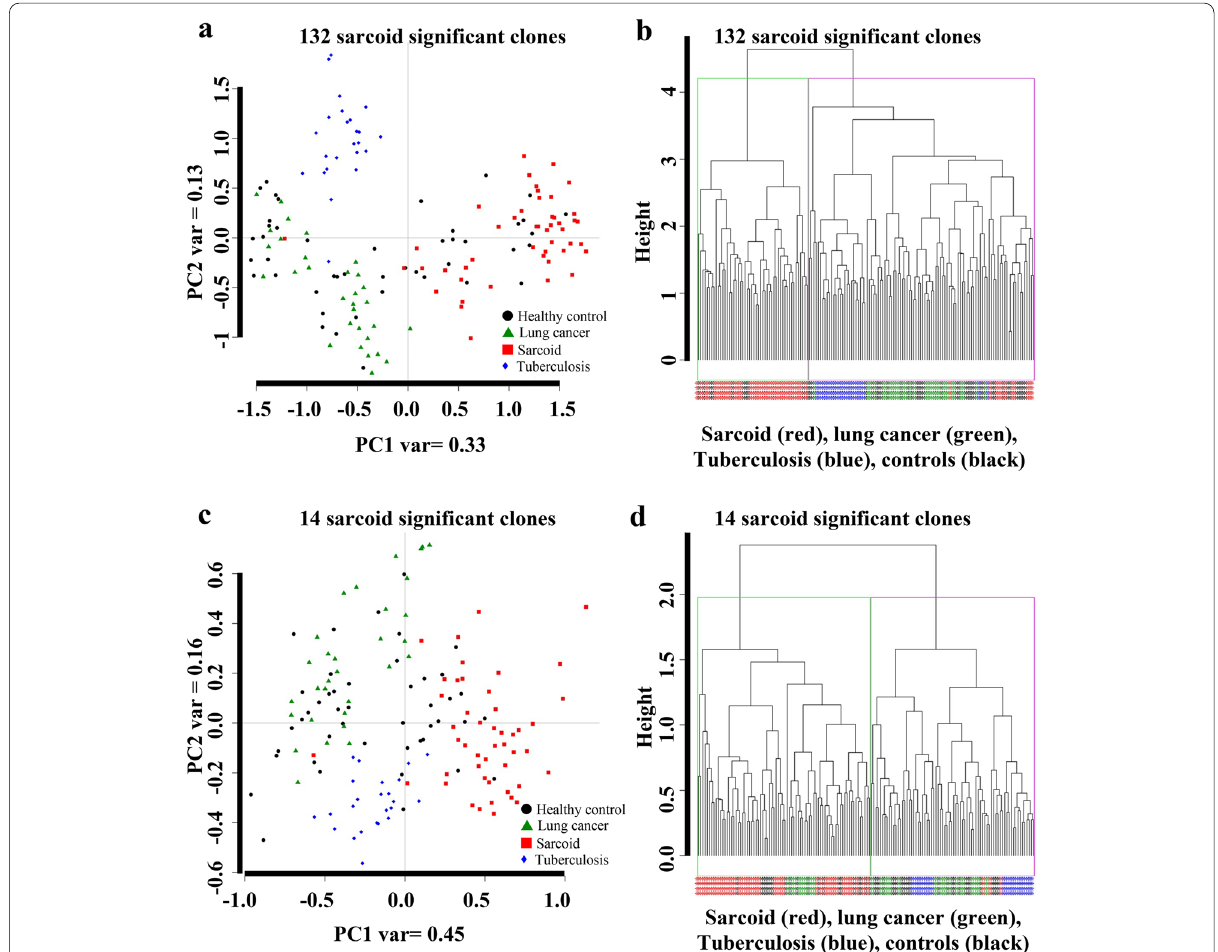
Fig. 2 a PCA plot along the PC1 and PC2 results when applied on 132 sarcoidosis clones (option 1). The PC1 explained 0.33 of variance, whereas PC2 explained 13% of the variance. As shown, the sarcoidosis samples are well separated from the lung cancer, TB and most healthy control samples. b Hierarchal clustering using the top 132 sarcoidosis clones (FDR < 0.05). c PCA plot generated with the top 14 sarcoidosis classifier clones. The PC1 explained 45% of the variance, whereas PC2 explained 16% of the variance. d Hierarchal clustering using the top 14 sarcoidosis clones. This figure demonstrates better clustering performance with the 132 sarcoidosis clones and the top 14 classifier sarcoidosis clones (FDR <